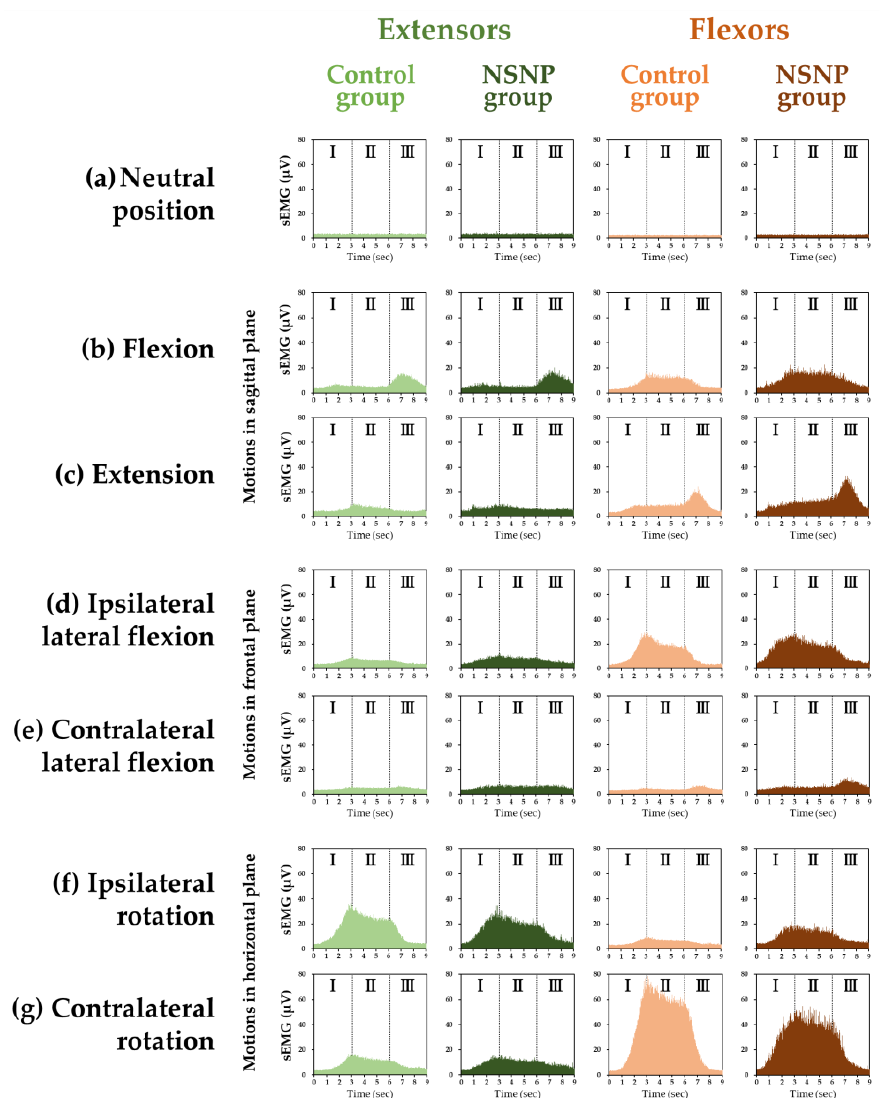
Figure 1. The grand ensemble average of sEMGs (surface electromyograms) of the cervical extensors and flexors ( a ) in the neutral position and during neck ( b ) flexion, ( c ) extension, ( d ) ipsilateral lateral flexion, ( e ) contralateral lateral flexion, ( f ) ipsilateral rotation, and ( g ) contralateral rotation in the control group and NSNP (nonspecific neck pain) group. “I” indicates “Phase I”, a 3 s period during a motion from the neutral position to the maximum range of motion. “II” indicates “Phase II”, a 3 s period of maintaining the neck at the maximum range of motion. “III” indicates “Phase III”, a 3 s period during the motion from the maximum range of motion to the neutral position. ( b , c ) Motion in the sagittal plane; ( d , e ) motion in the frontal plane; ( f , g ) motion in the horizontal plane. In each motion, the greenish color indicates the activity of the extensors, and the brownish color indicates the activity of the flexors. Dark green and brown indicate activity in the NSNP group; light green and brown indicate activity in the control